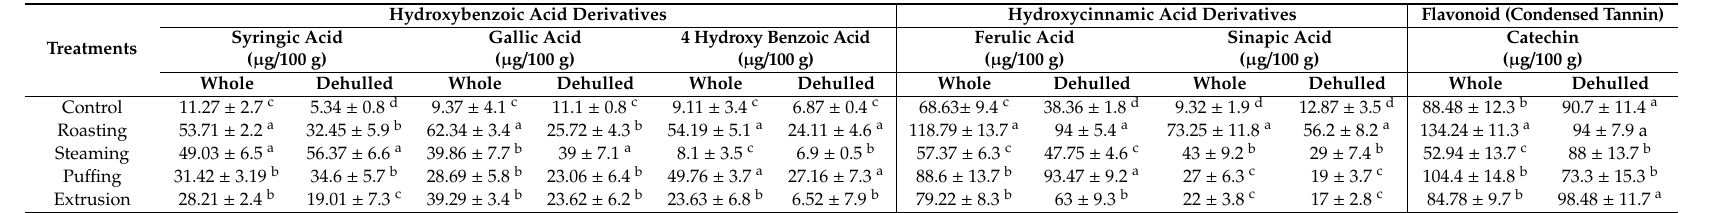
Table 2. Analysis of phenolic acids and catechin of processed millet by di ff erent